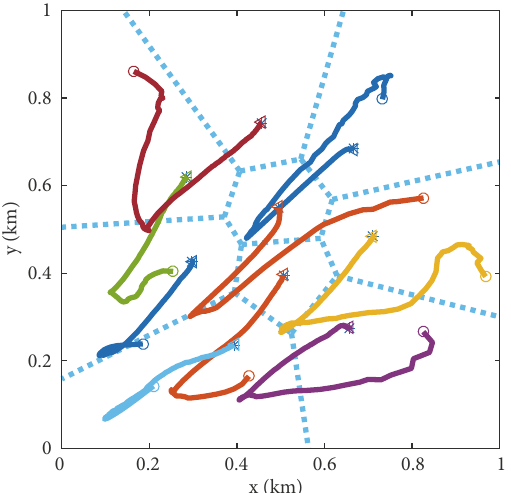
Figure 2: The coverage trajectories of agents.